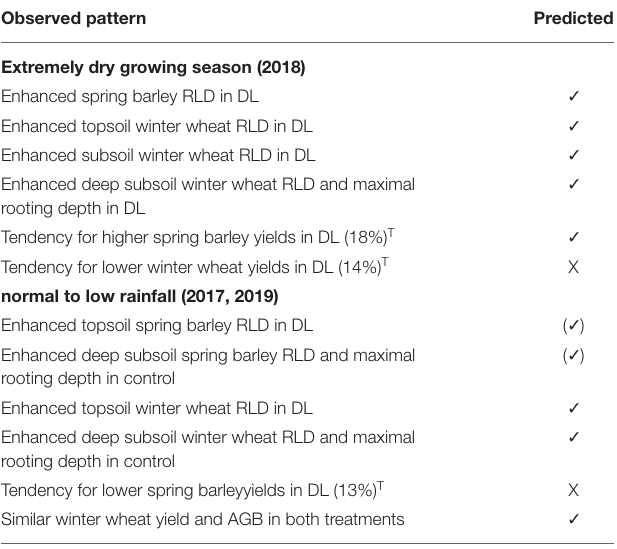
TABLE 4 | Observed growth pattern for 2017, 2019 (growth periods with low to normal rainfall), and 2018 (extremely dry growing period), and prediction of the respective pattern for the treatment with strip-wise subsoil loosening (DL) at the melioration strip and the control treatment ( 3 : pattern was predicted, ( 3 ): pattern was partly predicted, and X: pattern was not